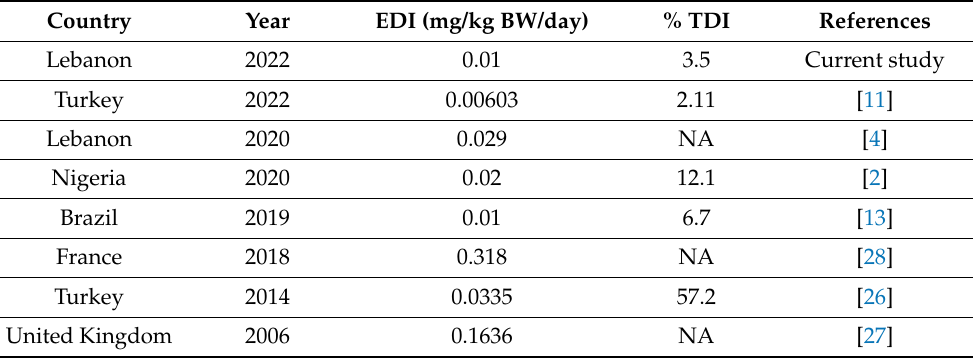
Table 6. Exposure assessment for aluminum in infant and child food samples from different countries around the